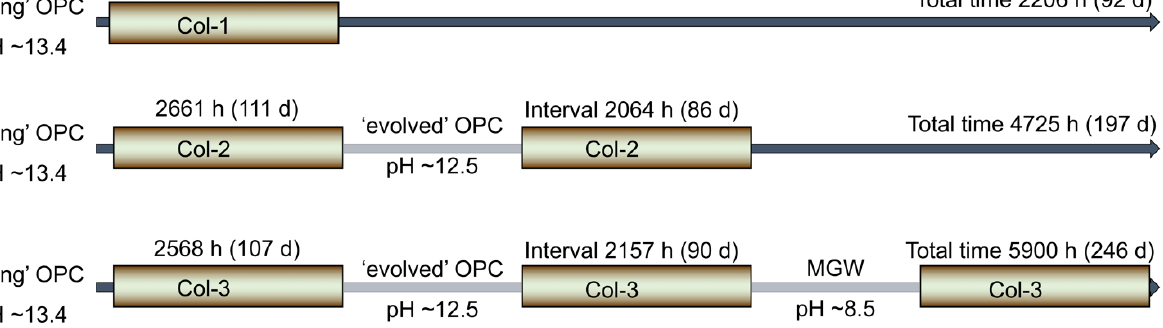
Figure 1. Schematic of column setup.